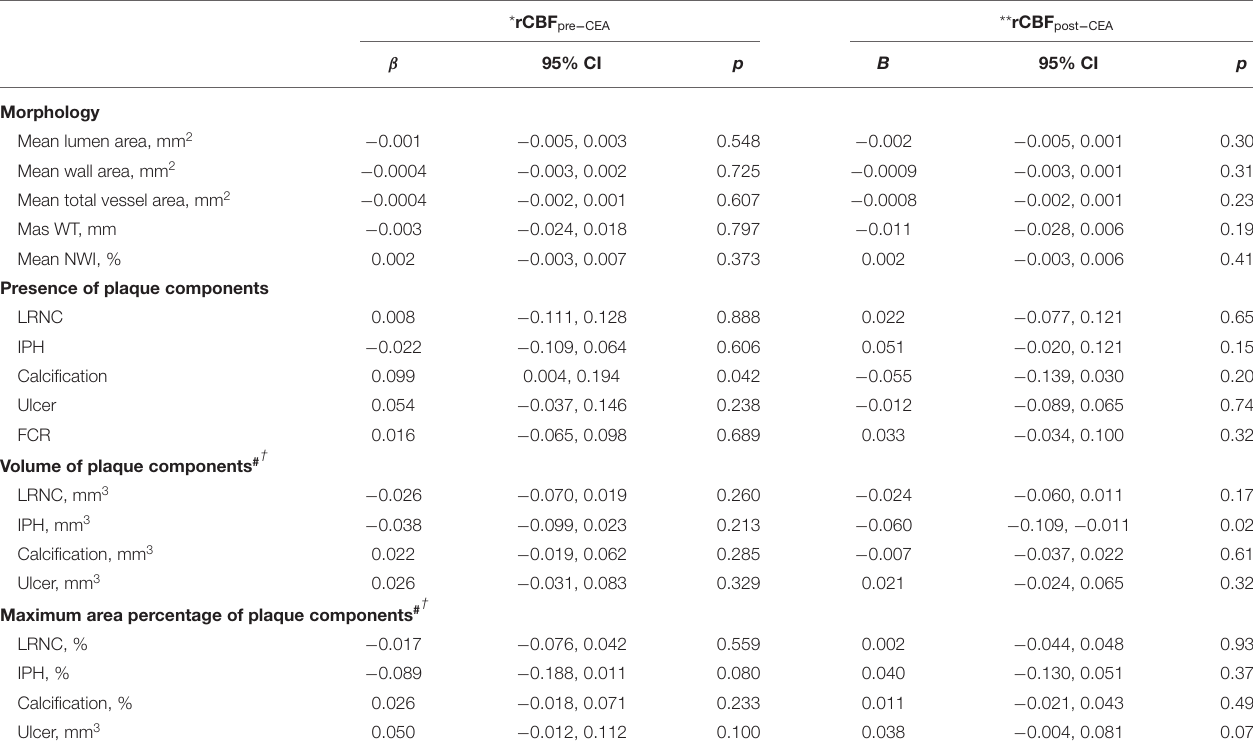
TABLE 5 | Multi-variate linear regression analysis between plaque characteristics and CBF ( n =